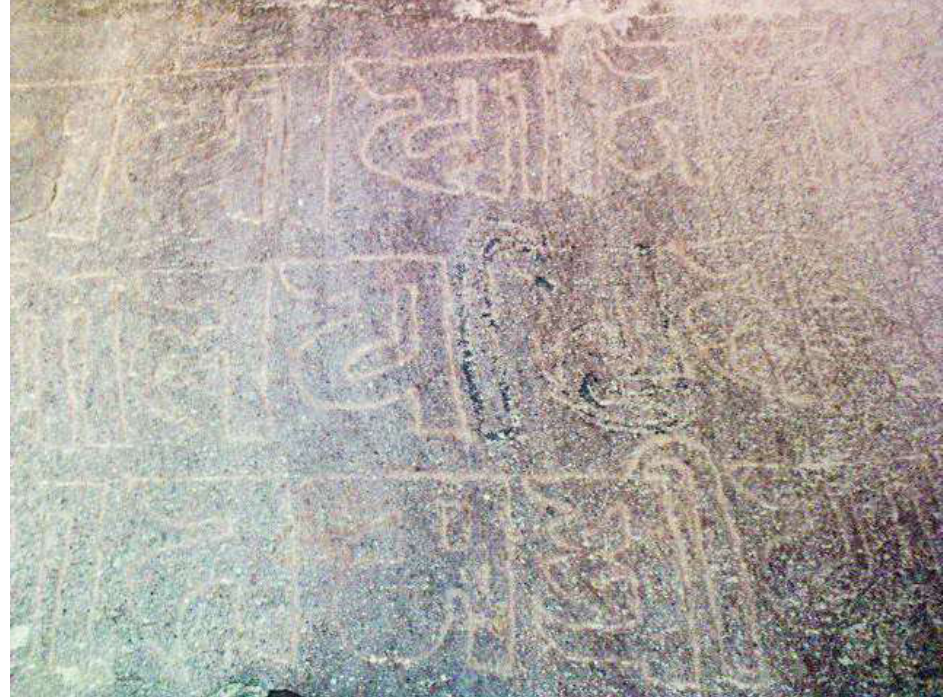
Figure 9. The Karimun Inscription on Karimun Besar Island in Riau Islands Province. Photo: Noel H.